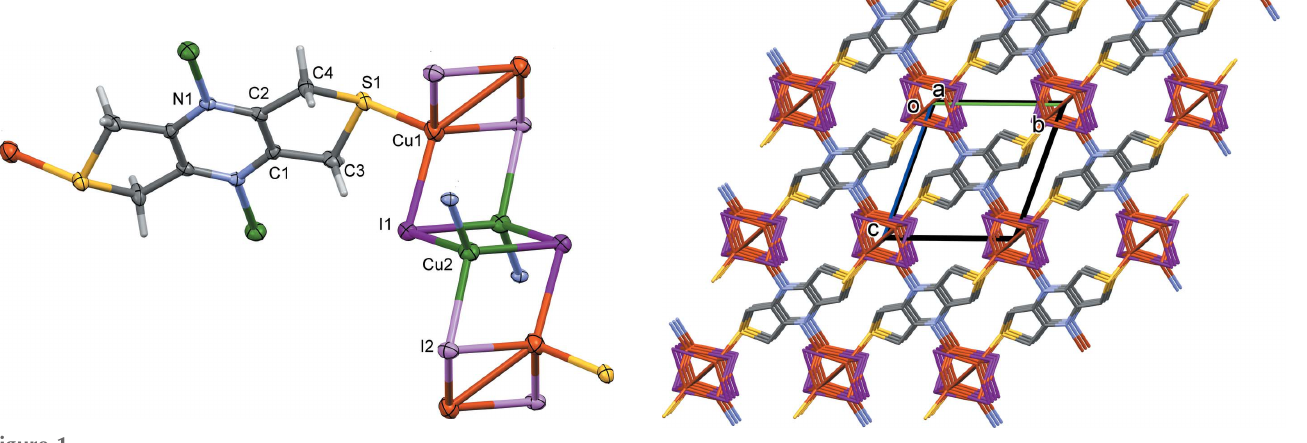
Figure 2 Aview along the a axis of the crystal packing of complex I . For clarity, the H atoms have been omitted.